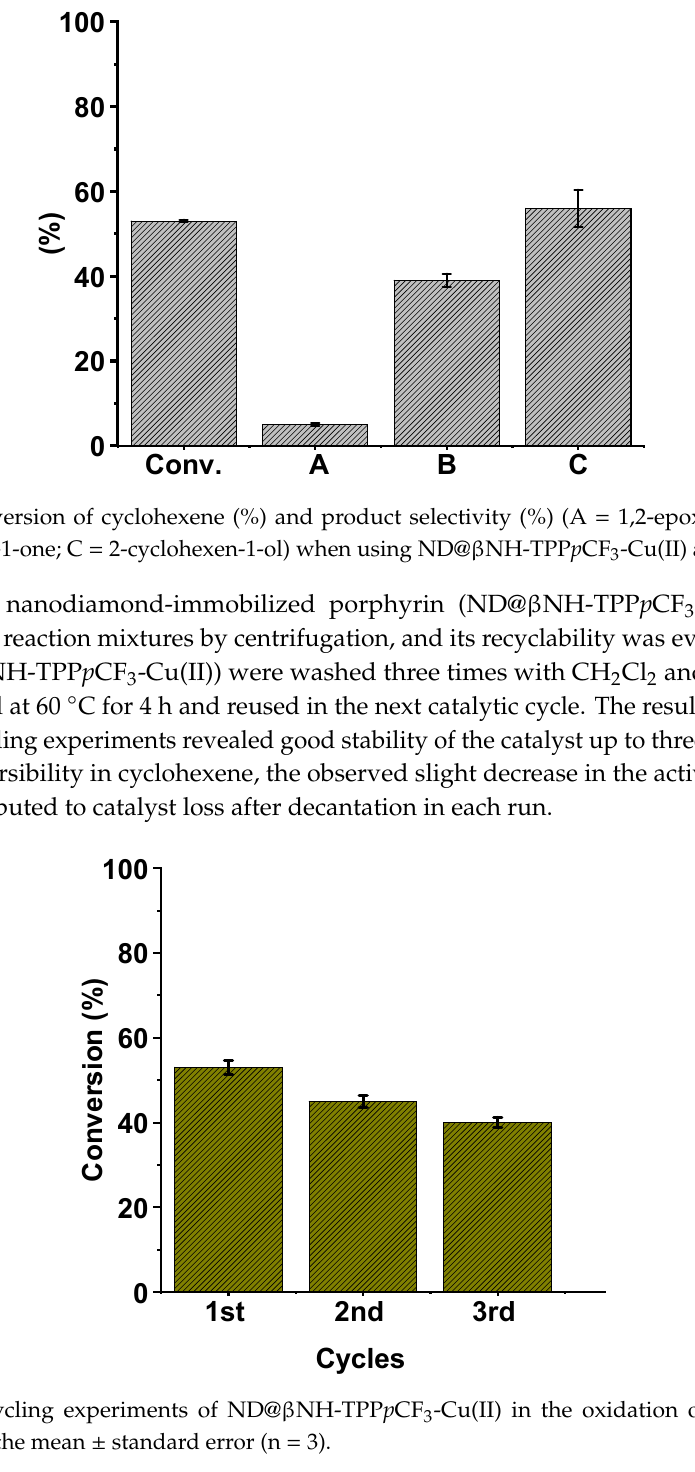
Figure 5. Recycling experiments of ND@βNH-TPP p CF 3 -Cu(II) in the oxidation of cyclohexene. Data represent the mean ± standard error (n = 3).